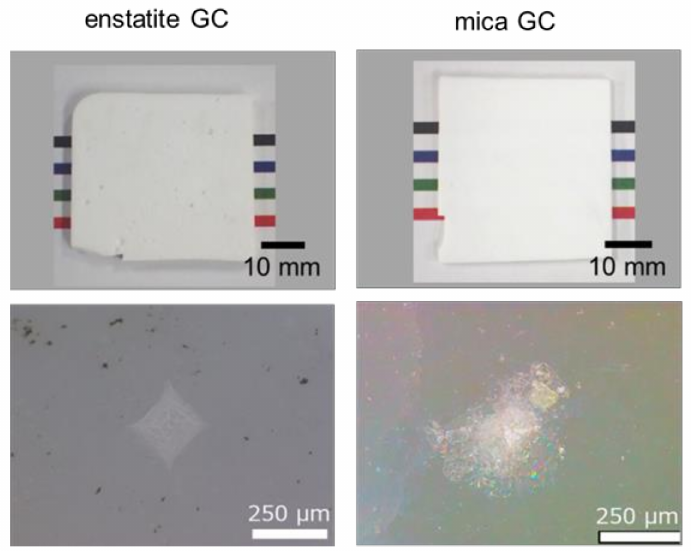
Figure 7. Appearances (sample thickness: 1 mm) and optical microscopy images of Vickers indenta- tion of the reference